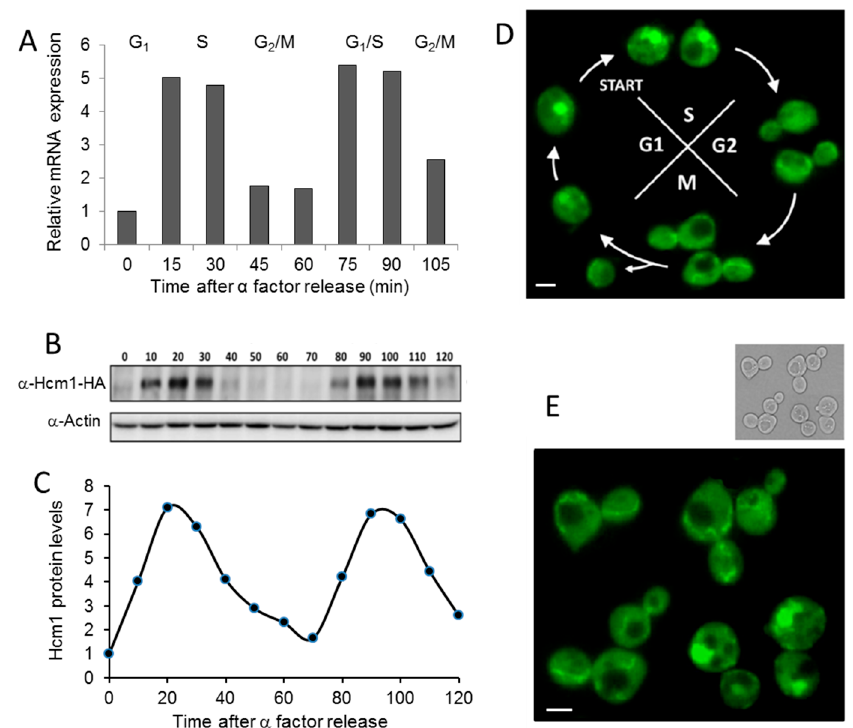
Figure 1. Cell cycle modulates the amount of Hcm1 and its localization. Cells grown exponentially were synchronized to G1 with α -factor for 2 h, and several parameters were determined at di ff erent times after release. ( A ) Hcm1 mRNA expression of WT ( HCM1-HA ) cells was determined by quantitative real-time PCR analysis. Actin expression was used as an internal control to normalize expression levels. ( B ) HA-tagged Hcm1 was analyzed by Western blot with anti-HA antibodies. Actin was used as a loading control. ( C ) Bands corresponding to Hcm1 in B were quantified, normalized by actin levels, and the relative intensities were calculated. ( D ) Pictures by fluorescence microscopy of HCM1-GFP cells were taken at di ff erent time points of the cell cycle. ( E ) Amplified fluorescent microscopy picture of several HCM1-GFP cells synchronized in the M phase. Scale bar, 1 µm.